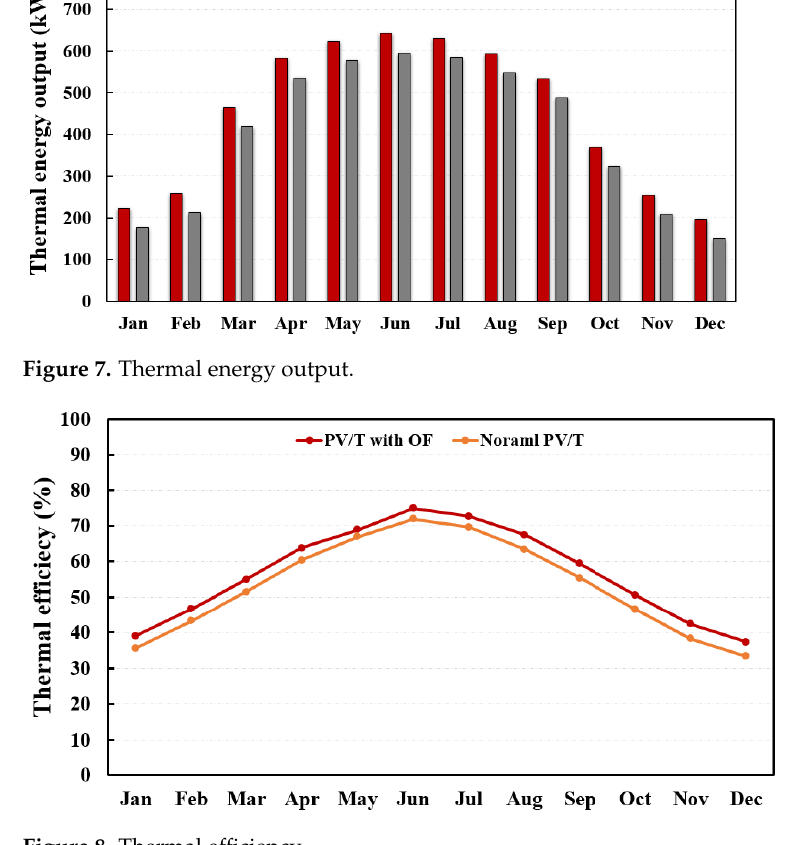
Figure 10. Heat pump COP. 4.3. Effect of Optical Filtration Channel Height It can be observed from Figure 11 that the height of the OF channel has a significant influence on thermal and electrical efficiencies. Specifically, the electrical efficiency is re- duced from 14.6% to 14.3% with the height of the OF channel, on the contrary, the thermal efficiency is improved from 67.1% to 67.8% with the rising of the OF channel height.